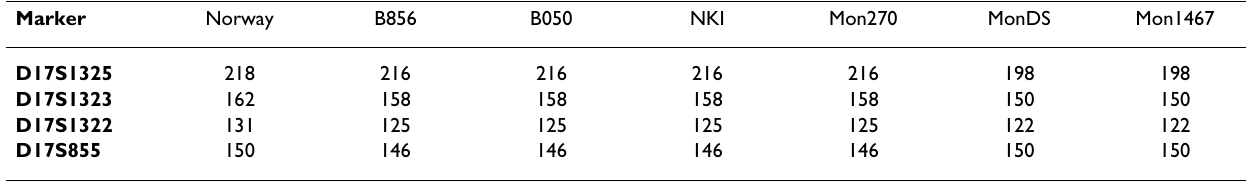
Table 1: Haplotype analysis of unrelated, BRCA1 1135insA carriers Marker Norway B856